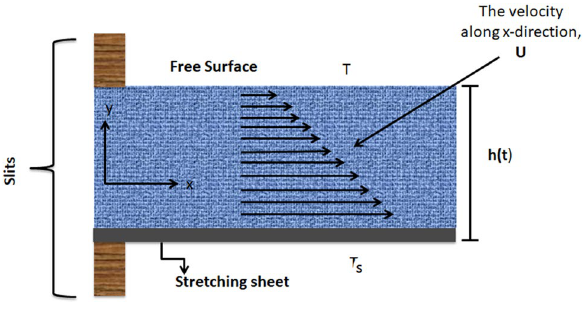
Figure 1. The flow of nanofluid composed by